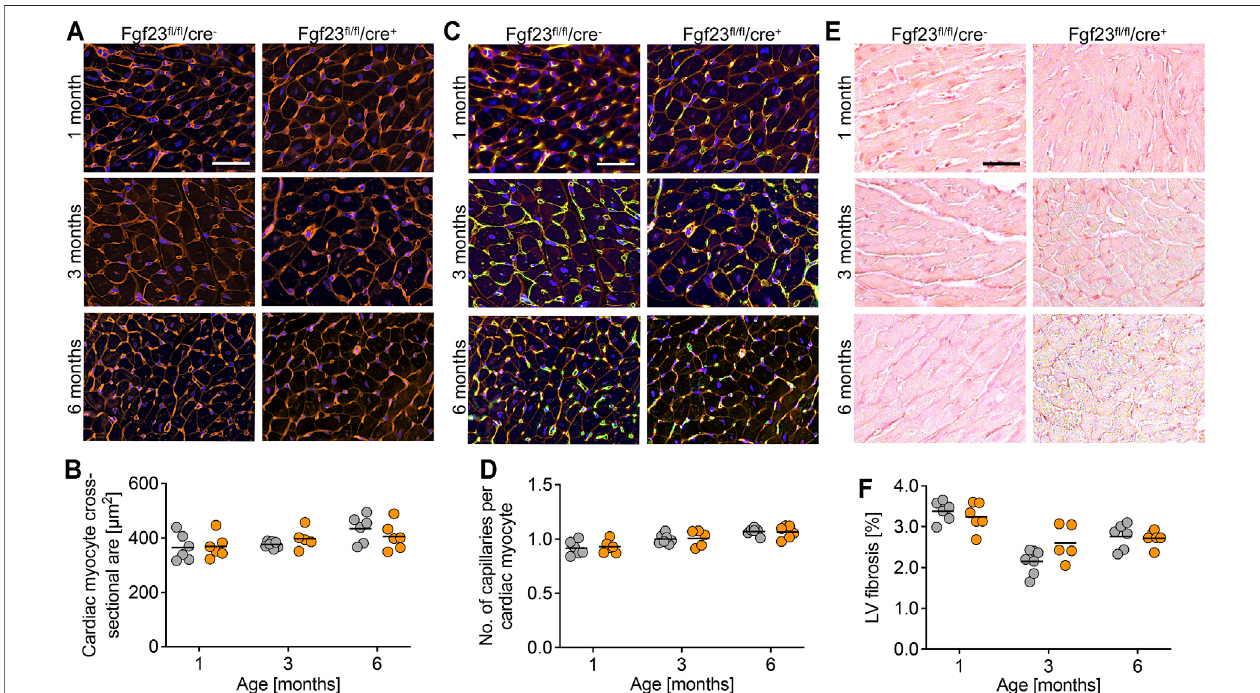
FIGURE 4 | Cardiac myocyte-speci fi c Fgf23 knockout mice do not show cellular and molecular changes in the heart. (A) Immuno fl uorescence staining of heart tissuefrom1,3and6 monthsoldFgf23 fl / fl /cre − andFgf23 fl / fl /cre + micewithwheatgermagglutinin(WGA)AlexaFluor555(red)andnuclei(blue).Magni fi cation × 20,scale bar 50 µm. (B) Quanti fi cation of cardiac myocyte cross-sectional area does not show differences between both genotypes. (C) Immuno fl uorescence co-staining for WGA (red), CD31 (green) and DAPI (blue) in heart tissue from 1, 3 and 6 months old Fgf23 fl / fl /cre − and Fgf23 fl / fl /cre + mice. Magni fi cation × 20, scale bar 50 µm. (D) Quanti fi cation of capillary number per cardiac myocyte does not differ between both genotypes. (E) Picrosirius red staining in heart tissue from 1, 3 and 6 months old Fgf23 fl / fl /cre − and Fgf23 fl / fl /cre + mice. Magni fi cation × 10, scale bar 50 µm. (F) Cardiac myocyte-speci fi c Fgf23 deletion does not induce left ventricular (LV) fi brosis, although differences over time are observed. Data is given as scatter dot plots with means analyzed by Two-way ANOVA followed by Tukey ’ s multiple comparison test; n (cid:2) 5 – 7 mice per group.